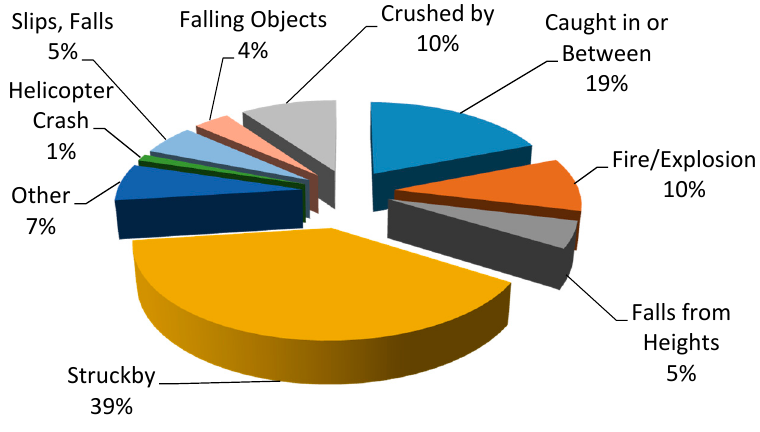
Figure 3. Accident Classification.